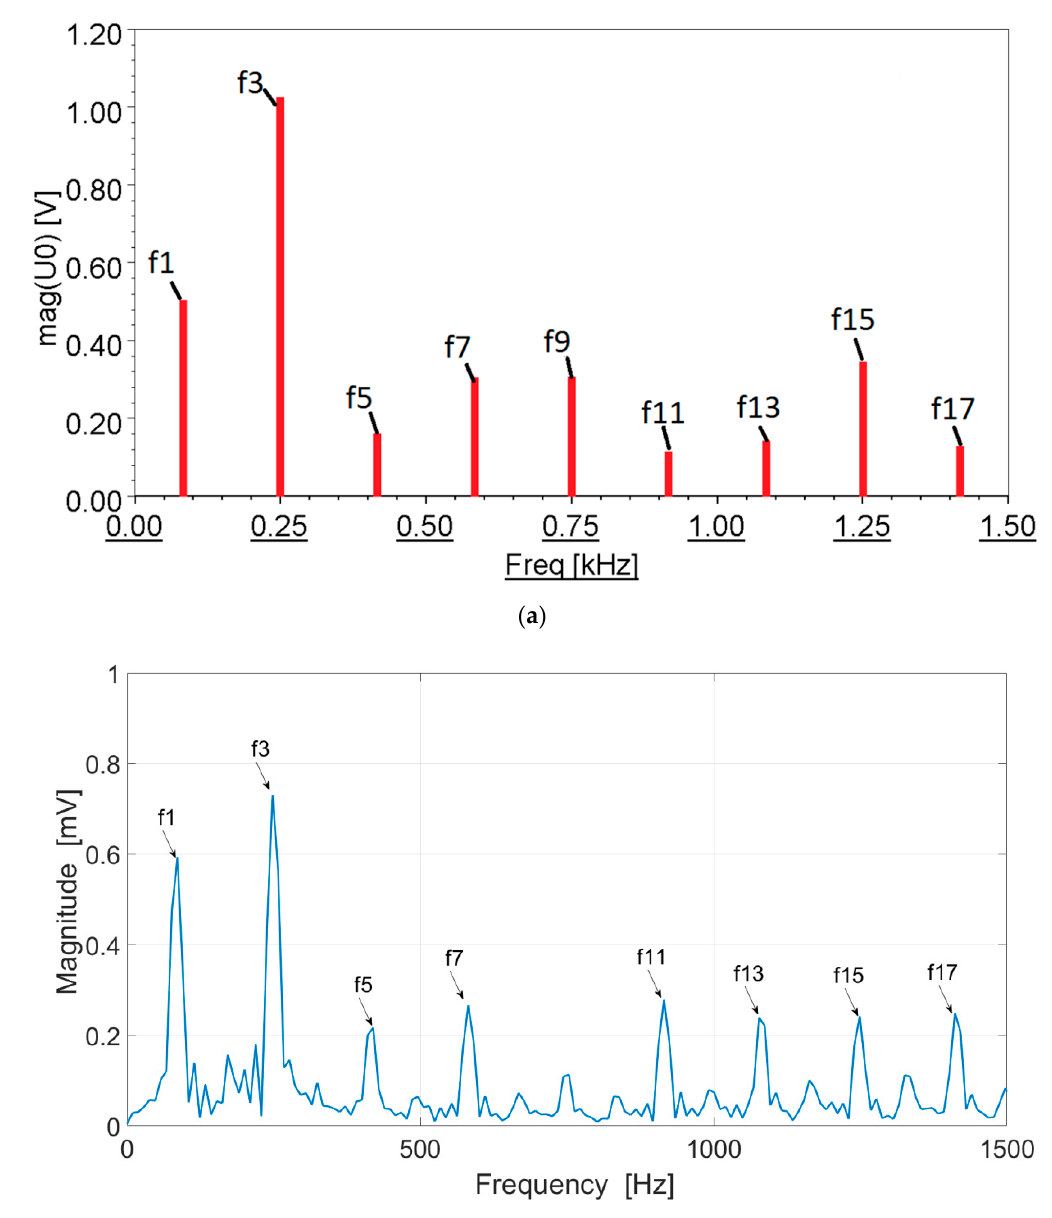
Figure 16. Delta ( ∆ ) configuration—FFT of neutral voltage u 0 with open OC1: ( a ) numerical calculations; Figure 16. Delta ( Δ ) configuration—FFT of neutral voltage u 0 with open OC1: ( a ) numerical ( b ) calculations; ( b ) measurements.